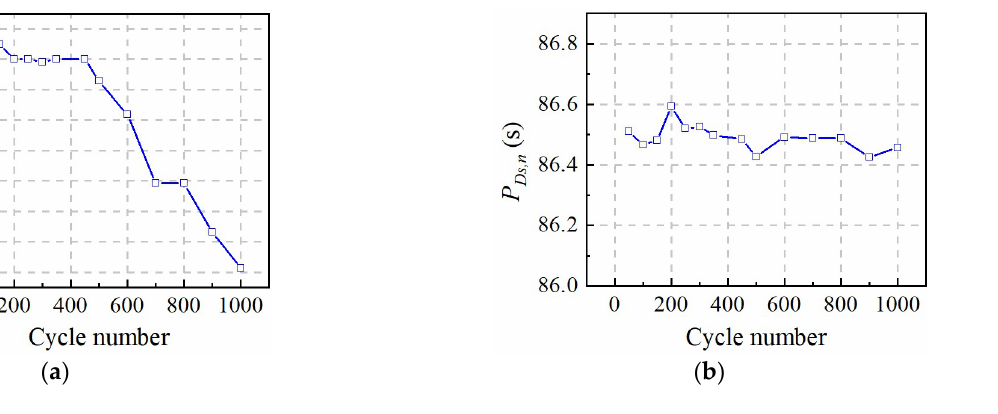
Figure 7. The identification results of health characteristic parameters of the negative electrode. ( a ) Negative electrode capacity; ( b ) Solid-phase diffusion ability.